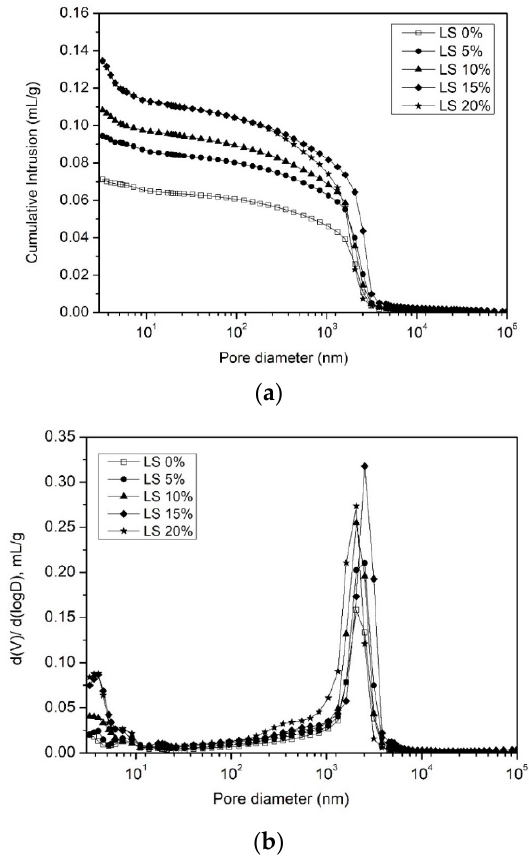
Figure 7. Mercury intrusion porosimetry results on MAPC mortar with limestone fines at different contents of 0–20%: ( a ) Cumulative intrusion and ( b ) pore size distribution.